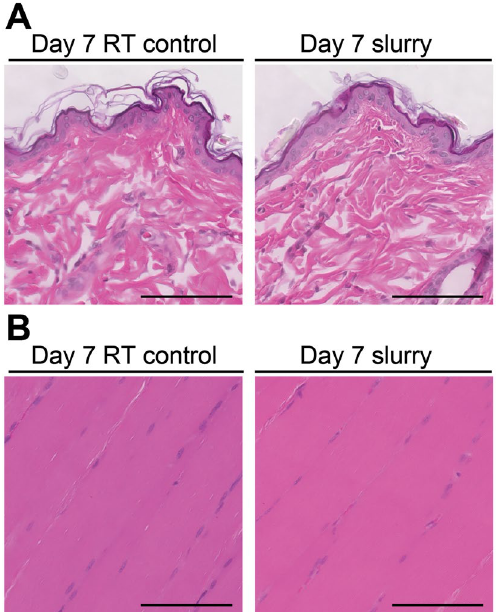
Figure 1. Slurry is selective to nerve tissue with no damage to surrounding skin or muscle tissue. Representative images of ( A ) skin, and ( B ) muscle tissue at the injection site stained with H&E at 7 days after injection of slurry; scale bar, 100 μm; RT, room